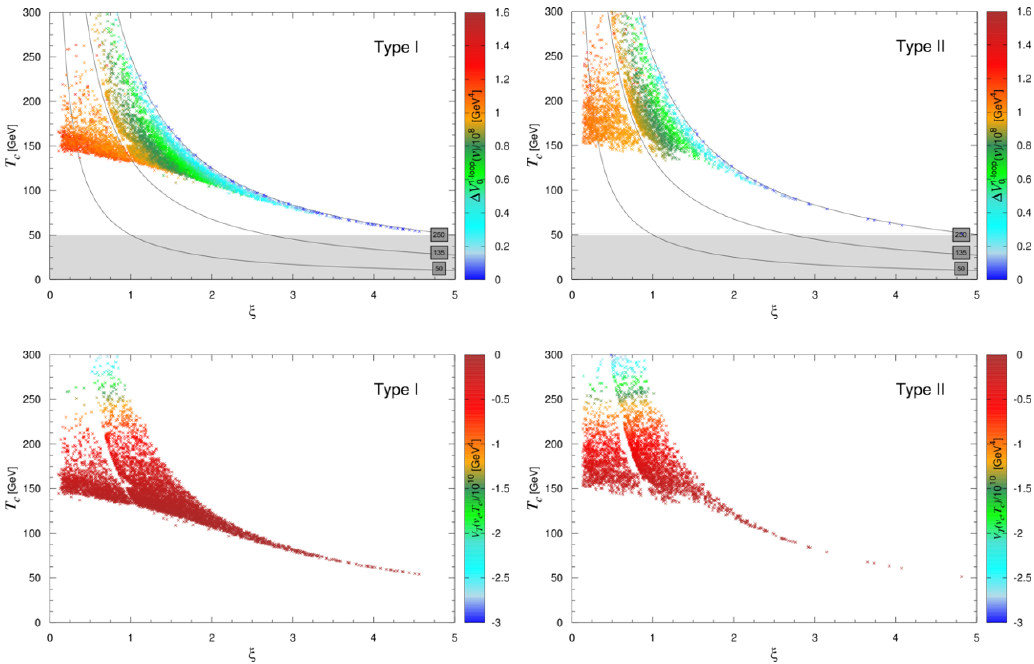
Figure 11 . Properties of (cid:12)rst order PT in the 2HDM. The z-axis in the upper and lower plots represents the vacuum depth of the zero temperature potential j (cid:1) V 1-loop tial in the broken vacuum at the critical temperature V T ( v c ; T c ), respectively. Only T c . 300 GeV points are